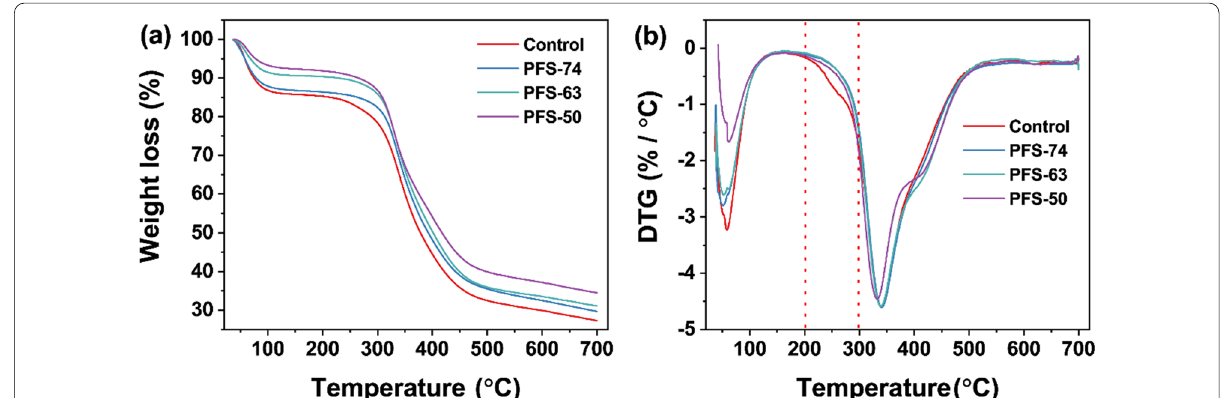
Fig. 6 a Weight loss and b differential thermogravimetry (DTG) curves of PFSs retanned and control leathers